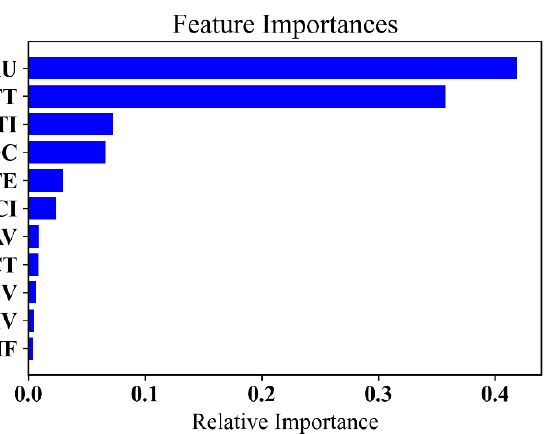
Figure 8. The magnitude of influence of complexity indicators on workload estimation.